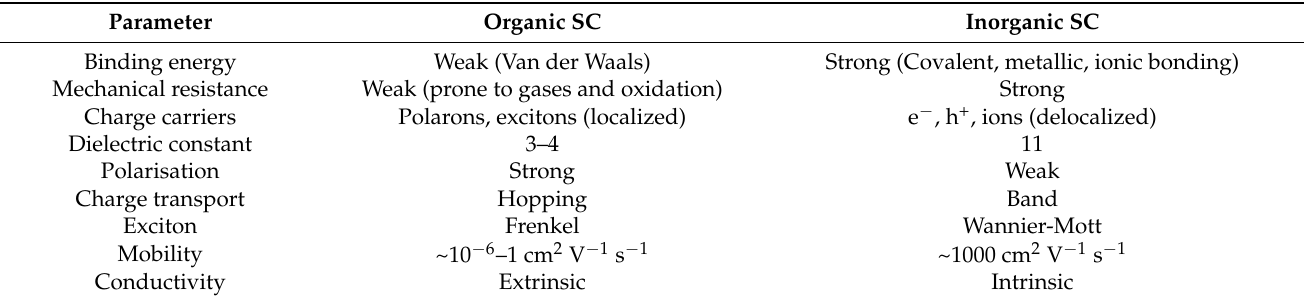
Table 1. A comparison of organic and inorganic semiconductor materials [48,53,54,57].